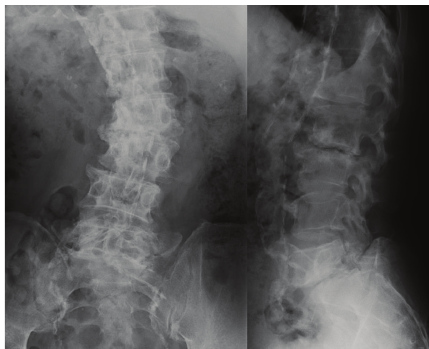
Figure 2: Preoperative plain radiographs showing progression of scoliosis and destructive changes at L2-L3 and L5-S1.